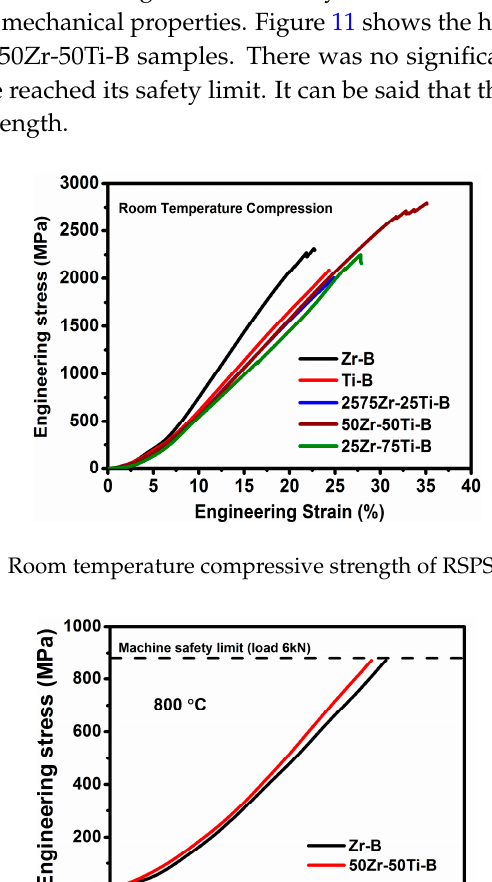
Figure 11. High temperature compressive strength of RSPSed samples.